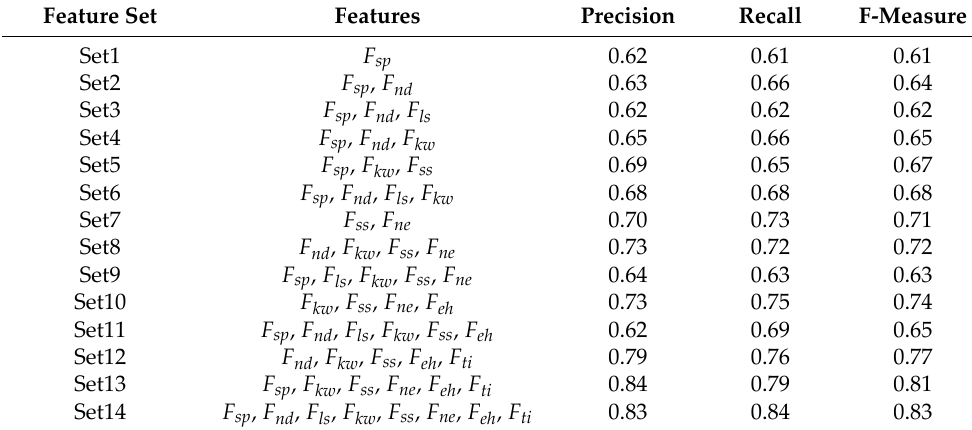
Table 8. Evaluation measure for 50% compression